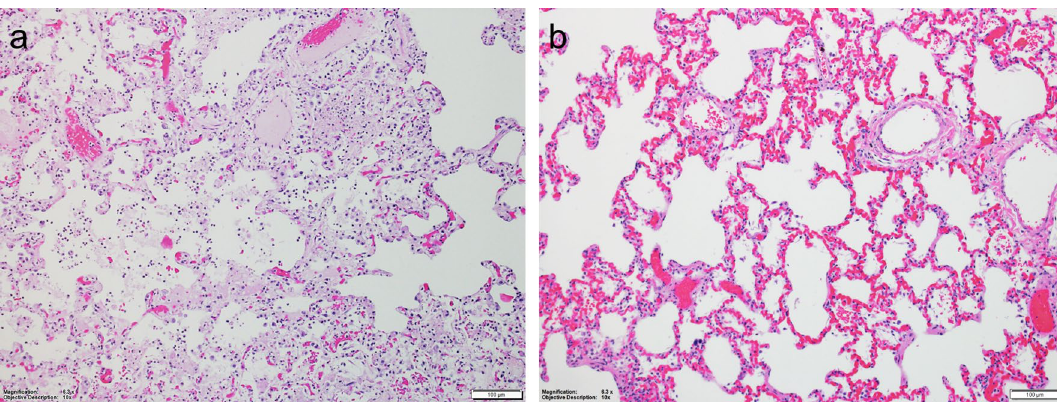
Figure 5. Lung histology. ( a ) Lung from vehicle-treated NHP (100× magnification). Focally extensive area of alveolar necrosis and edema are shown. ( b ) Lung from remdesivir-treated NHP survivor (100× magnification). Mild congestion is